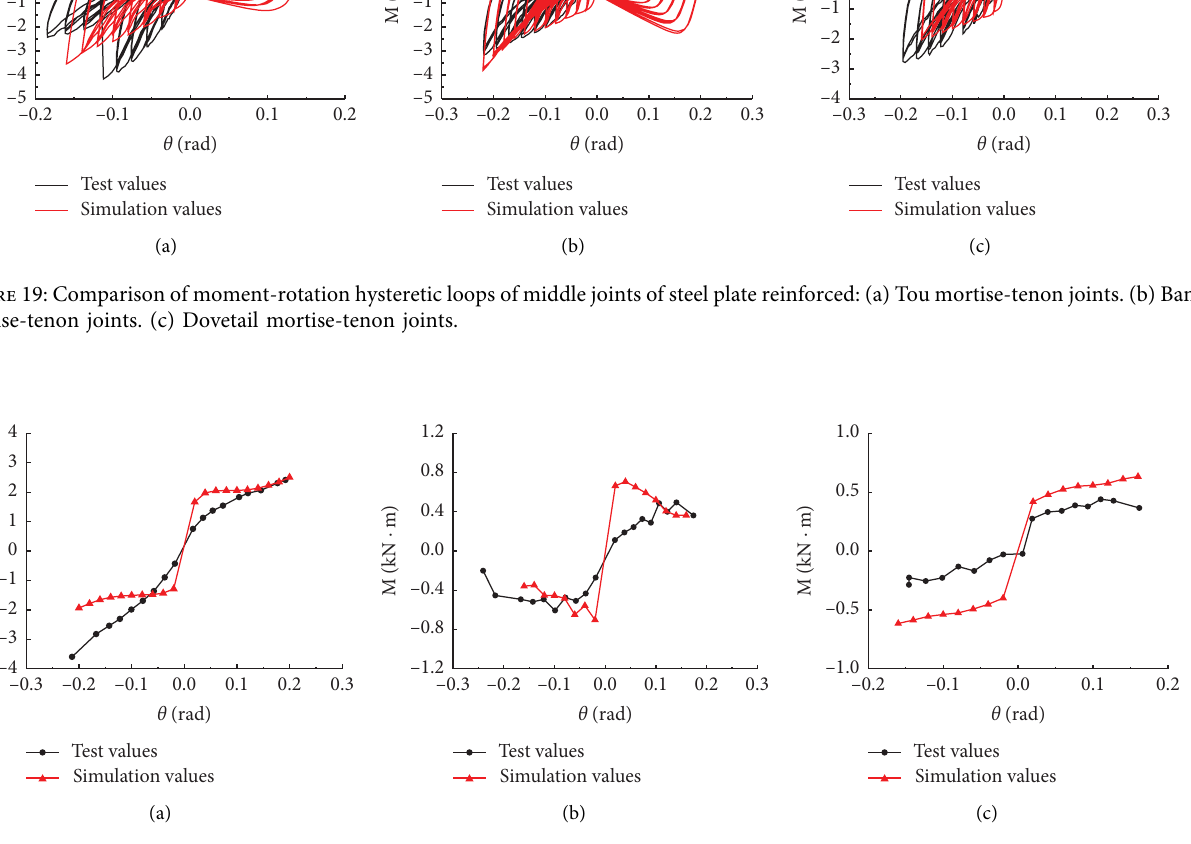
Figure 20: Comparison of moment-rotation backbone curves of unreinforced joints: (a) Tou mortise-tenon joints. (b) Ban mortise-tenon joints. (c) Dovetail mortise-tenon joints.